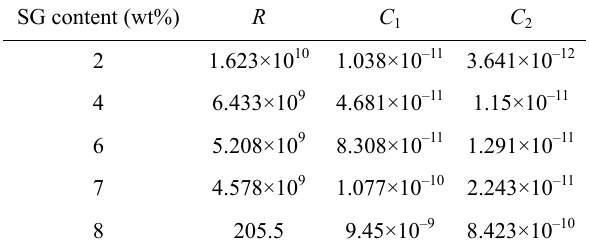
Fig. 16 Impedance spectra of the SG/AlN composites of (a) 2, (b) 4, (c) 6, (d) 7, (e) 8 wt%, and (f) equivalent circuit model of a microregion in the composites. Table 2 Modeled parameters of the equivalent circuit model in the SG/AlN